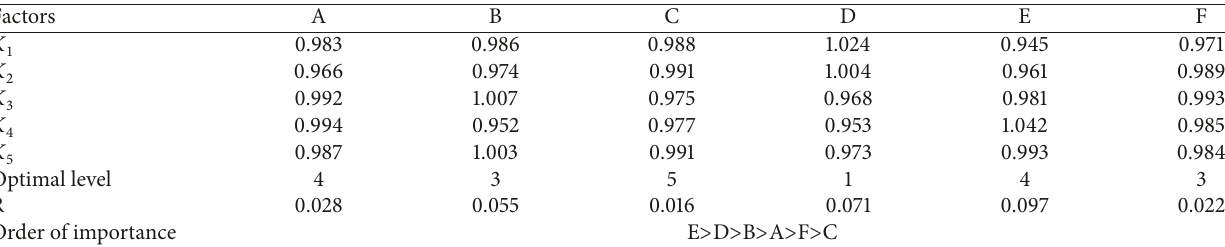
Table 4: Results of range analysis.